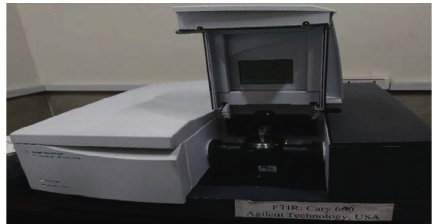
Figure 20: Experimental setup of FTIR.